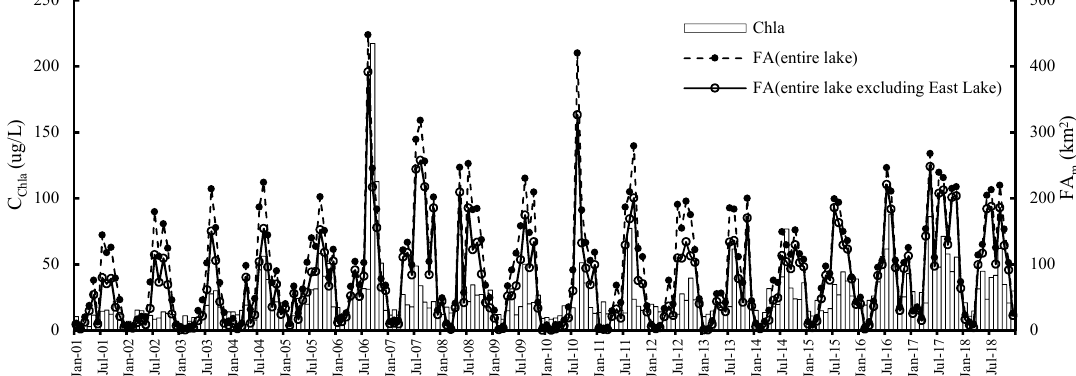
Figure 3. Comparison between monthly mean chlorophyll-a concentration ( C Chla ) and monthly mean floating cyanobacteria area (FA m ) of entire lake and entire lake excluding East Lake.